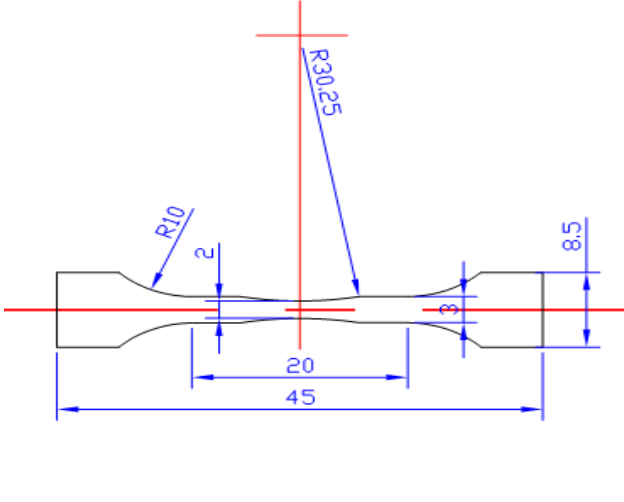
Figure 1. Dimension of specimens for in situ SEM observation tests (the thickness of the samples is about 0.7–1.0 mm, and all dimensions unit: